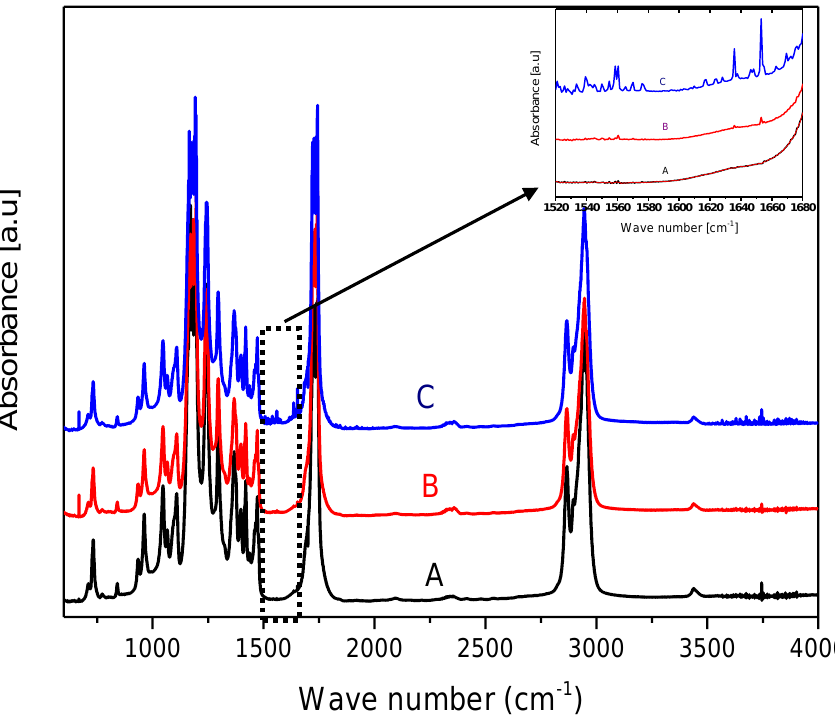
Figure 2. Fourier transform infrared (FTIR) spectra of the various films: (A) unmodified poly( ε -caprolactone) (PCL), (B) PCL treated with the 0.1 M arginine solution for 24 h at T = 25 ◦ C, (C) PCL treated with the 0.5 M arginine solution for 1 h at T = 40 ◦ C. The two additional peaks at the range from 1550 to 1650 cm − 1 in aminolysed PCL films (C) indicated the introduction of amine groups onto the PCL substrates.